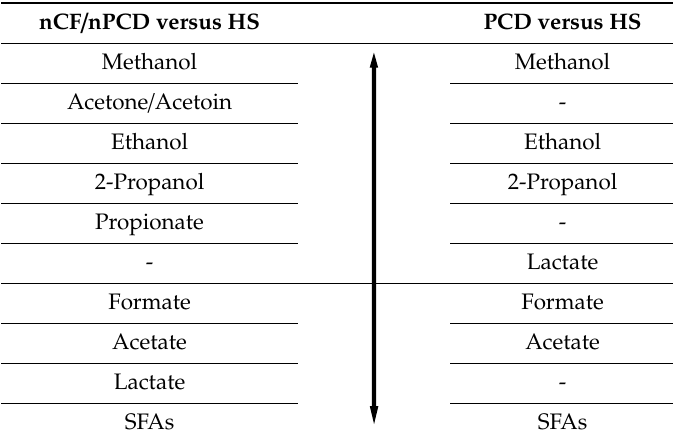
Table 2. Discriminating metabolites for the OPLS-DA models comparing nCF / nPCD and PCD bronchiectasis with healthy subjects (see Figures 3 and 4 for details). Gray arrows in the central column indicate the increase (up) or decrease (down) of metabolites in nCF / nPCD (left column) and in PCD (right column) with respect to HS a .